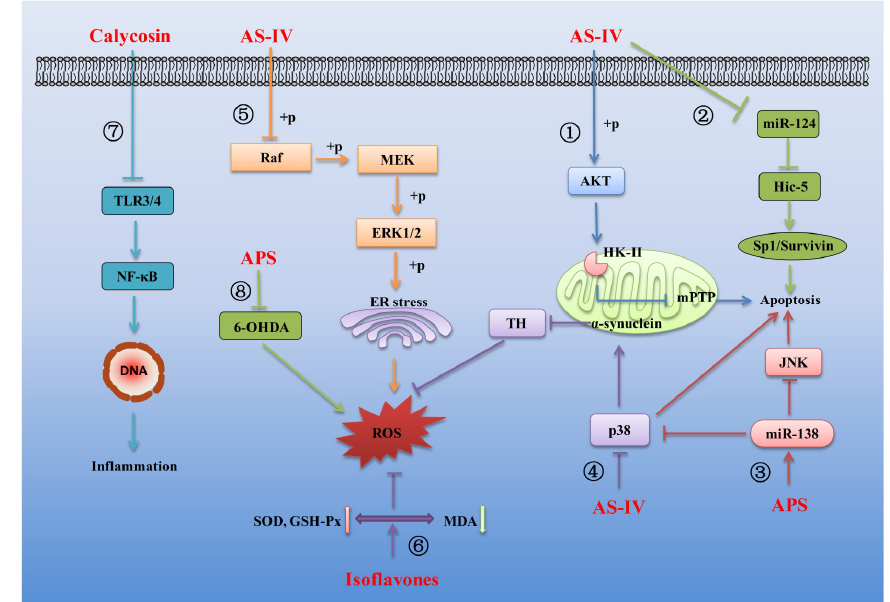
Figure 6. Several mechanisms linking AR and its main components to the treatment of nervous system diseases. Arrows and bar-headed lines represent signaling activation and inhibition, respectively. The different signaling pathways regulated by AR and its components are numbered ① to ⑧ .